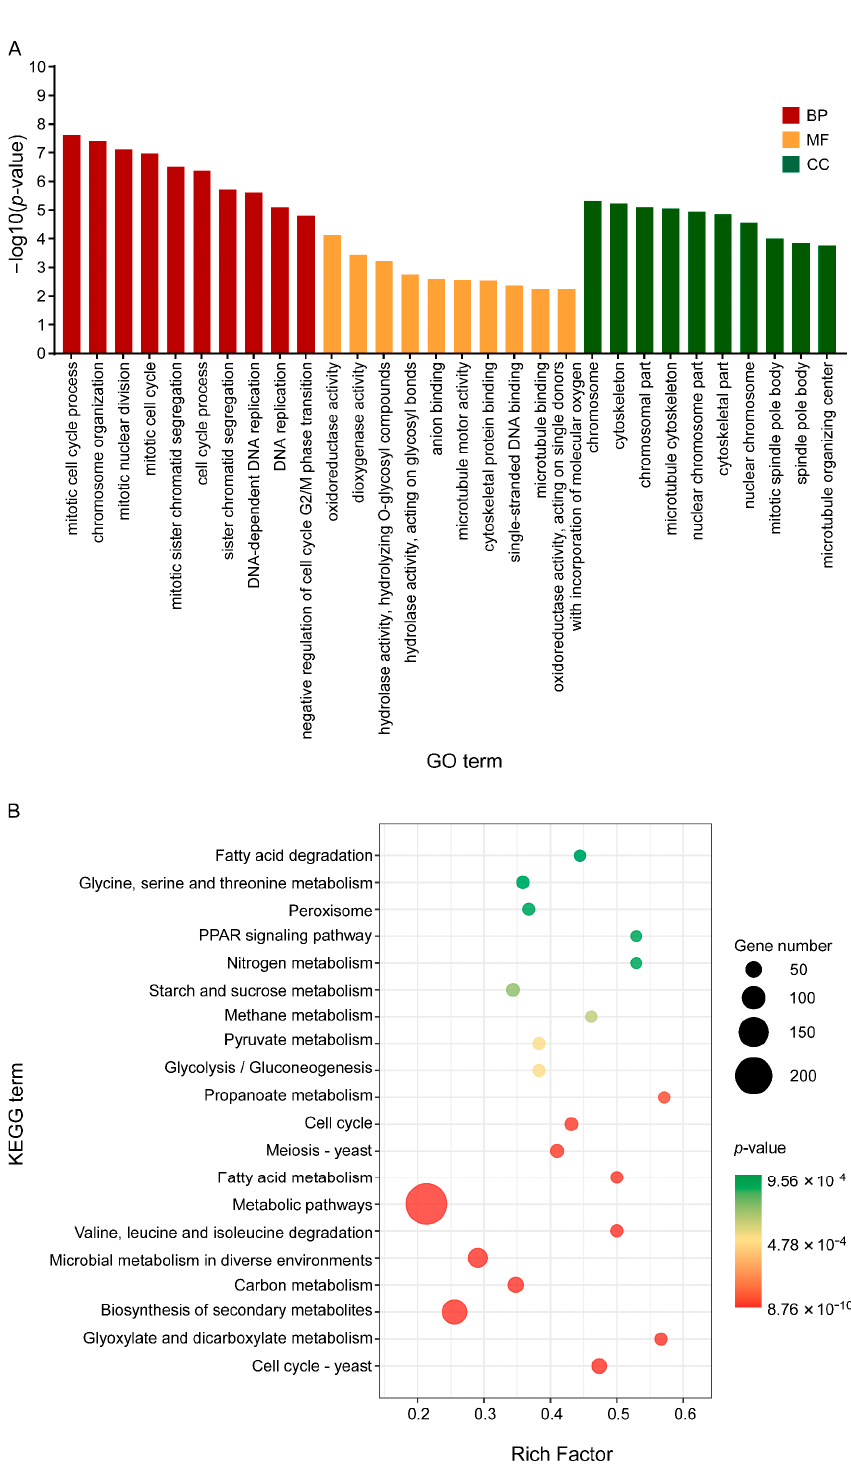
Figure 5. GO and KEGG enrichment map of the common C17-mycosubtilin-responsible genes with C17 mycosubtilin treatment at 2 and 6 h. ( A ). GO functional classification of the DEGs by p -value. The x-axis indicates different GO terms, and the y-axis indicates − log10 (corrected p -value) in each category. The top 10 enriched pathways of each category are shown in the figure. ( B ). Scatter plot of enriched KEGG pathways. The rich factor is the ratio of the number of genes that were differentially expressed to the total number of genes in a certain pathway. The top 20 enriched pathways are shown in the